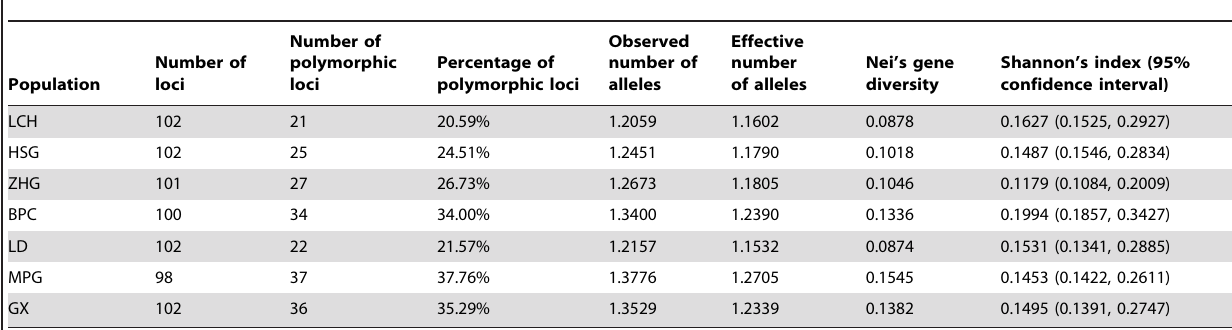
Table 3. Summary statistics revealed in seven populations of Alsophila spinulosa by using 20 ISSR primers.